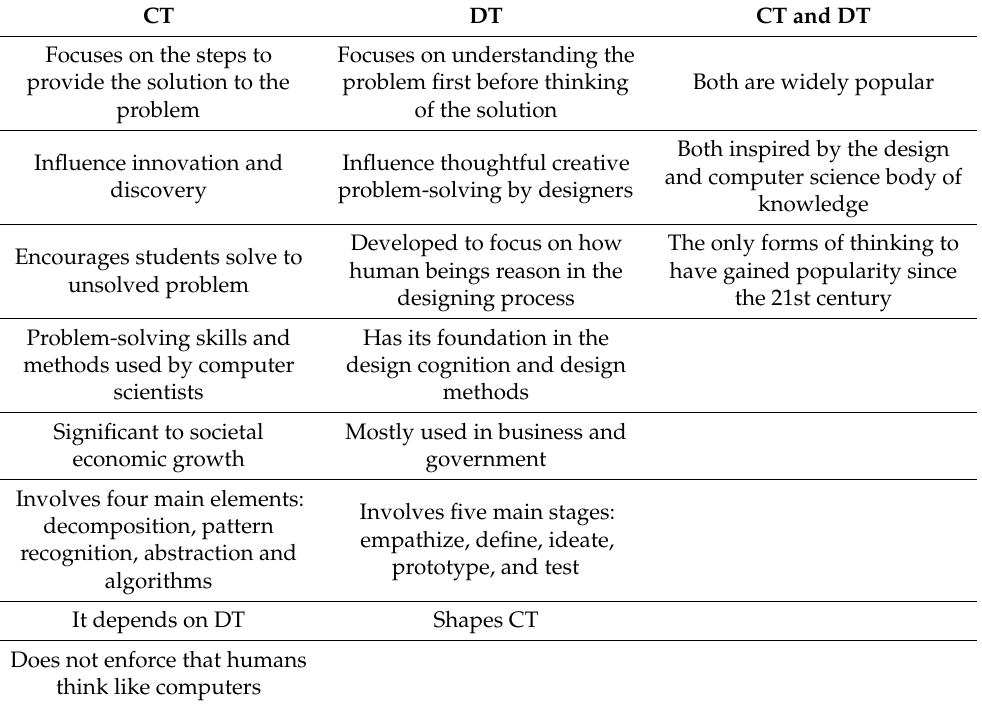
Table 1. CT and DT